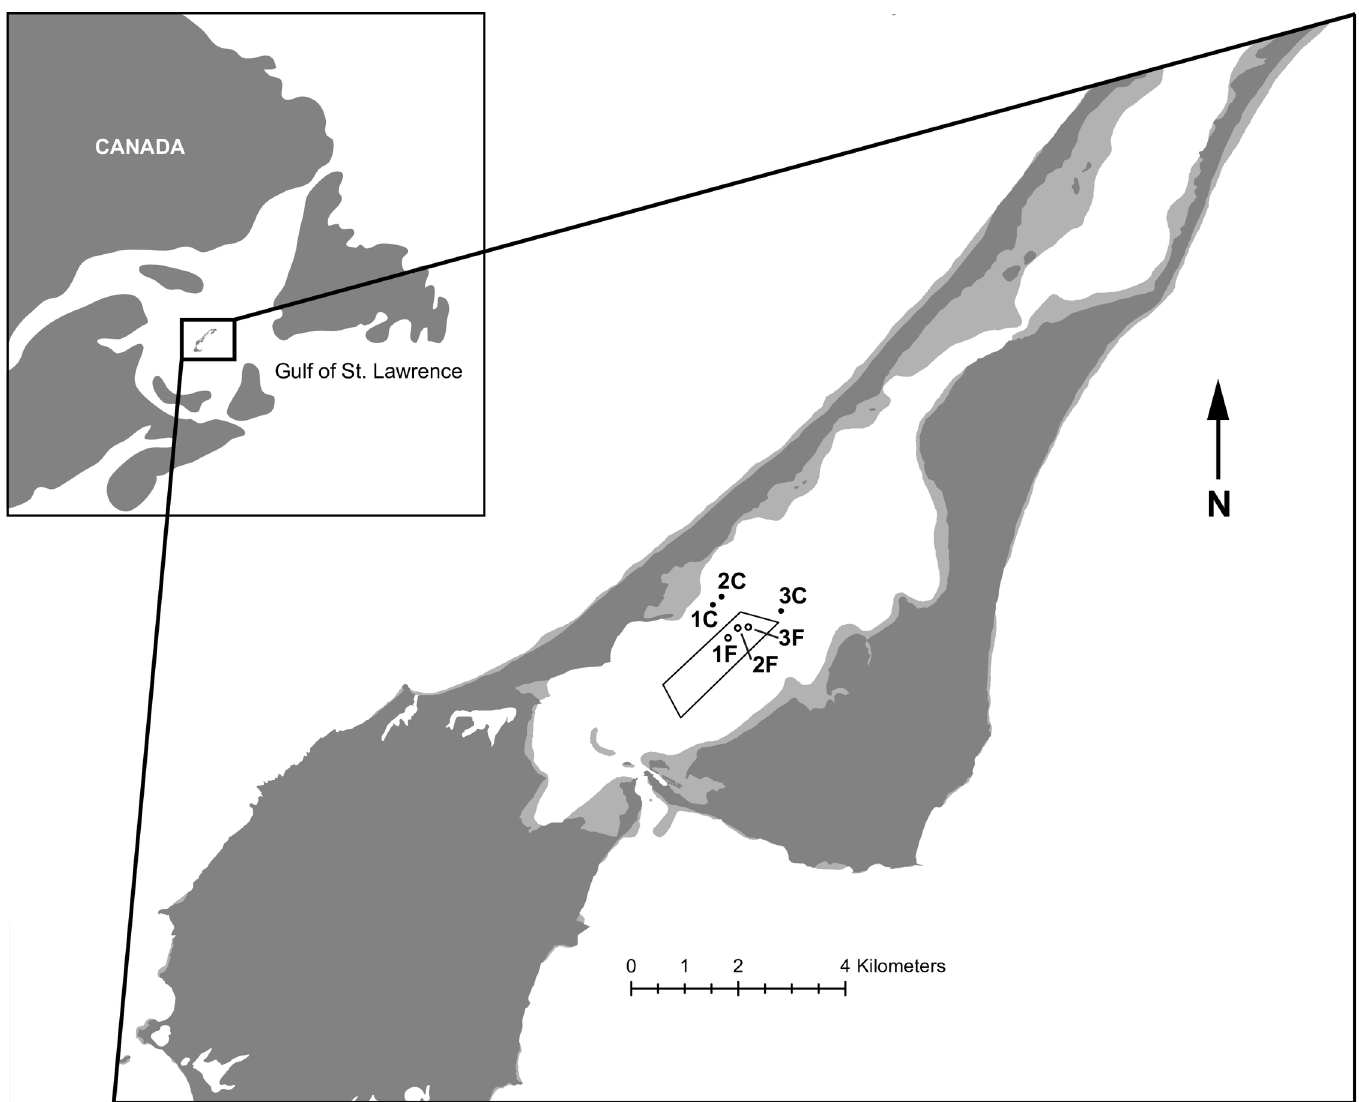
Fig 1. Map and location coordinates of the experimental sites in Iles de la Madeleine (Québec), eastern Canada. (Farm site 1F: 47°25.754' N, 61° 49.105 ’ W; Reference site 1C: 47°26.089' N, 61°49.328 ’ W; 2F: 47°25.85' N, 61°48.965 ’ W; 2C: 47°26.168' N, 61°49.196 ’ W; 3F: 47°25.858' N, 61°48.807 ’ W; 3C: 47°26.009' N, 61°48.321 ’ W). The bathymetry outlines are from Énergie et Ressources naturelles Québec and the outline of the Canadian coast line from Statistics Canada.